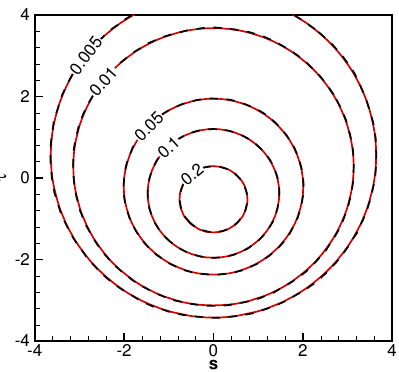
Figure 17. Diffuse plate, pressure contours, C p , d ( s , τ ) , S 0 = 2.0, T w / T 0 = 1.5, α 0 = 60 ◦ . Plate lengths are normalized by the nozzle diameter. Solid: analytical; dashed: DSMC.